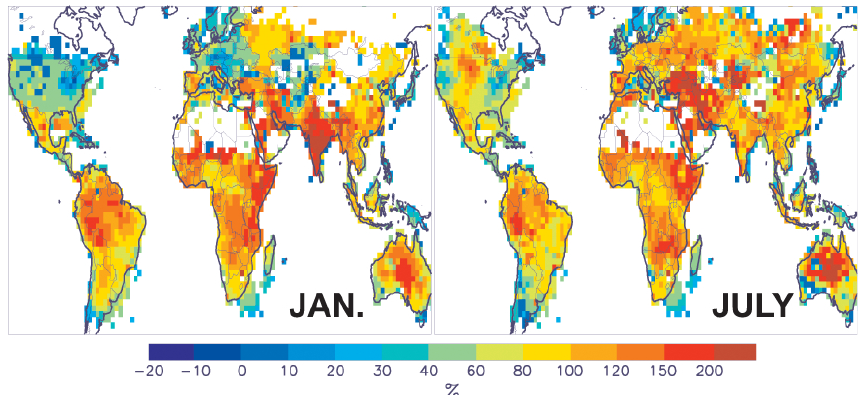
Fig. 7. Percentage difference between inferred total NO x emission in simulations MINLOSS and MAXLOSS for January and July